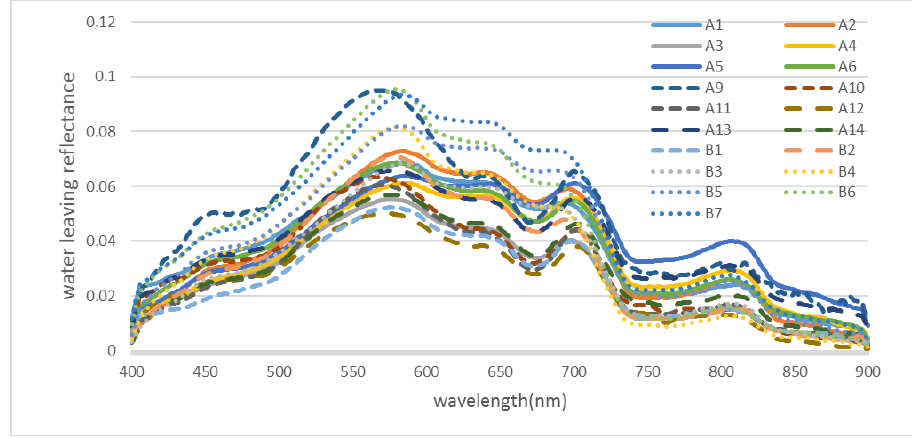
Figure 8. In situ observed spectral curves of water leaving reflectance at the sampling sites.